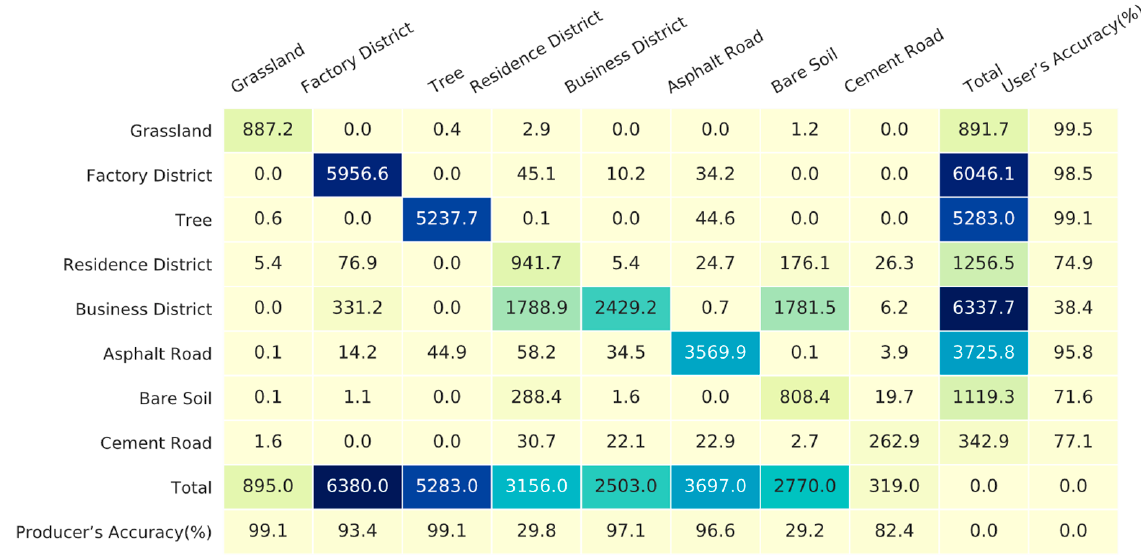
Figure 8. Confusion matrix of the classification results obtained when 32-angle images were selected as input data (representing the average values obtained in 10 iterations).